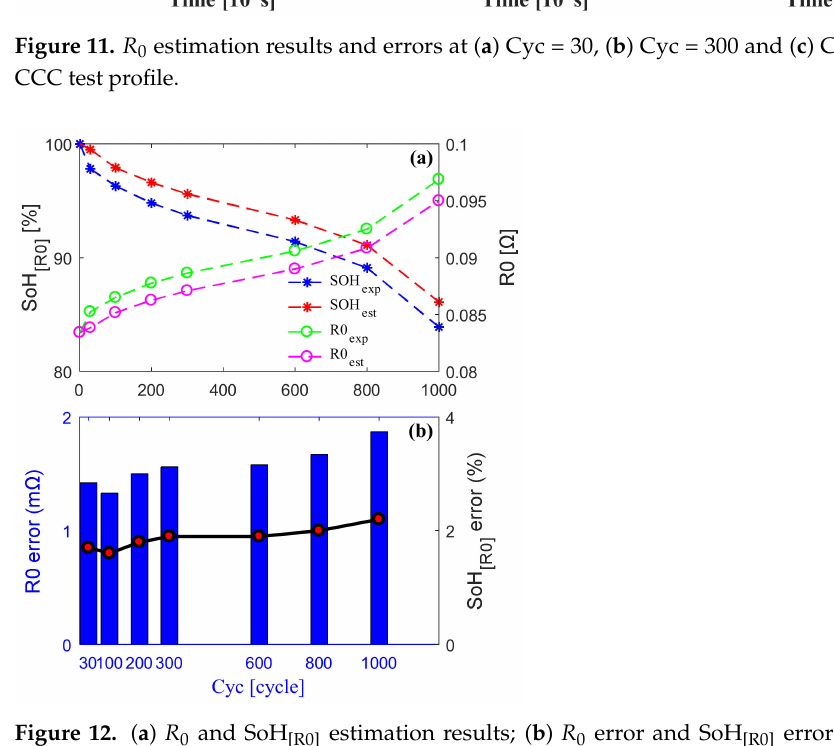
Figure 12. ( a ) R 0 and SoH [R0] estimation results; ( b ) R 0 error and SoH [R0] error under different cycle